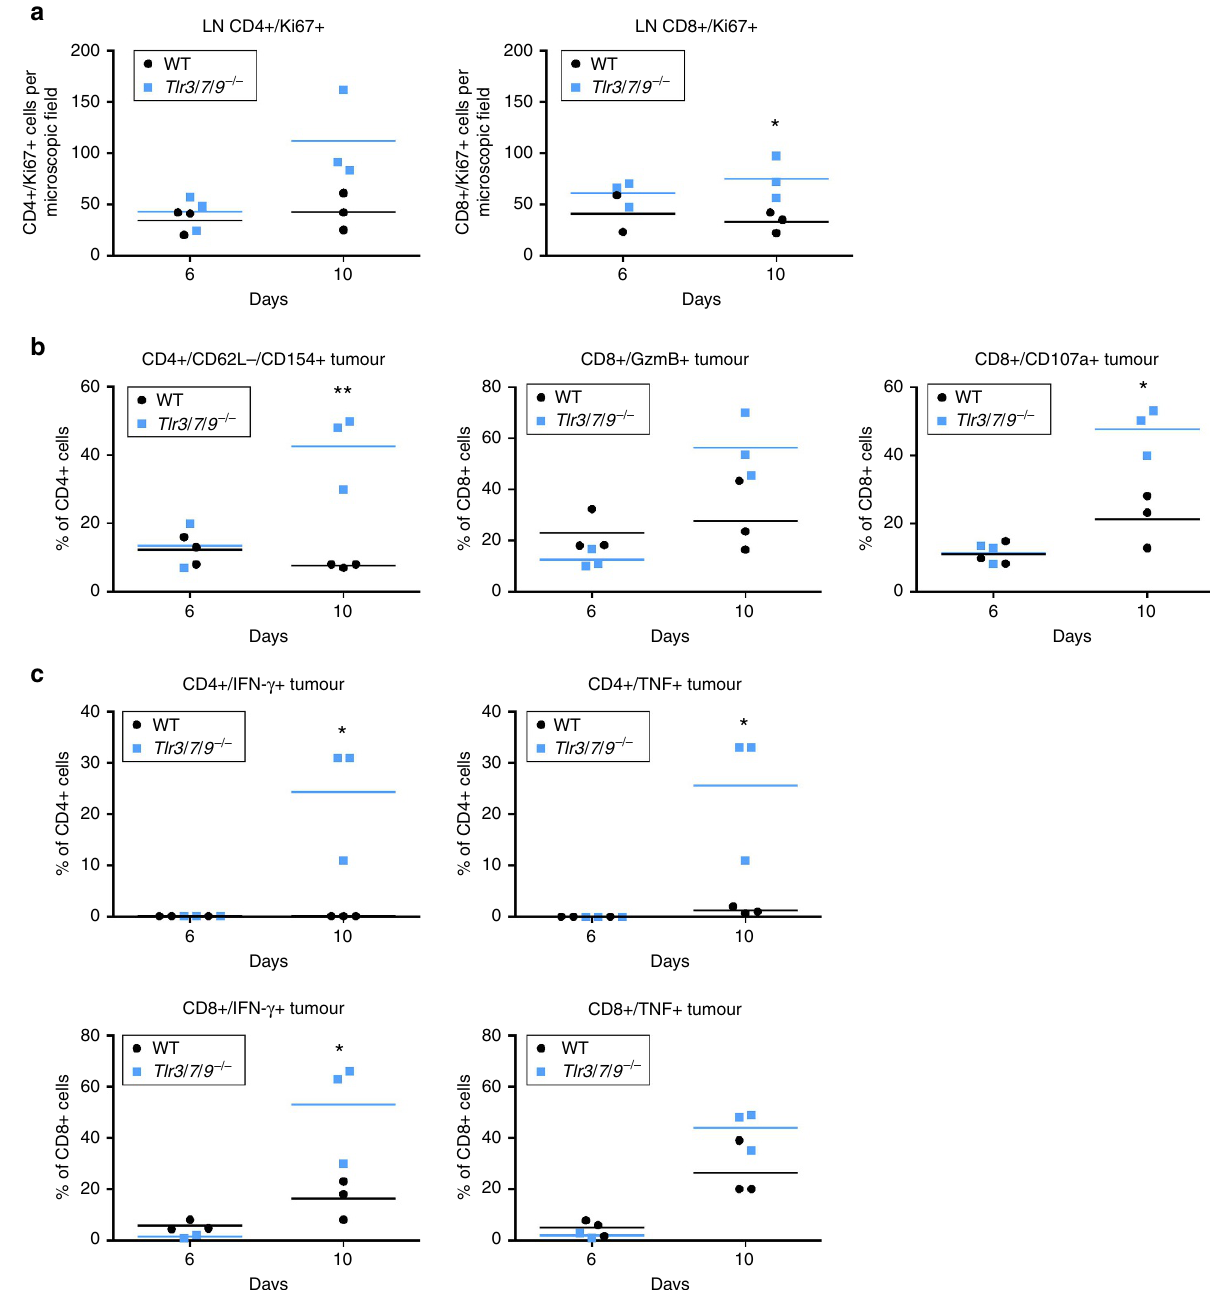
Figure 5 | T-cell activation in lymph nodes and tumour. ( a ) Lymph nodes: number of proliferating cells within the tumour-draining lymph nodes (LNs) of 6- to 12-week-old C57BL/6 WTand Tlr3/7/9 (cid:2) / (cid:2) mice was assessed at day 6 and day 10 by immunofluorescence double staining of frozen sections using a CD4 and a Ki67 antibodies. Quantification of positive cells was performed by observer-assisted counting on four randomly selected (cid:3) 200 magnified images per sample ( n ¼ 3). ( b , c ) Tumour: flow cytometric analysis of T-cell activation of tumour-infiltrating lymphocytes of 6- to 12-week-old C57BL/6 WT and Tlr3/7/9 (cid:2) / (cid:2) mice at day 6 and day 10. ( b ) Activation status of CD4 þ cells was analysed by staining of CD62L (cid:2) /CD154 þ cells. Activated CD8 þ cells are determined by showing Granzyme B þ (GzmB) and CD107a þ expression. ( c ) Cytokine production of tumour-infiltrating CD4 þ and CD8 þ cells was assessed after ex vivo stimulation with a CD3/CD28 antibodies and subsequent flow cytometry staining using a IFN- g and a TNF- a antibodies. Single values and mean (horizontal line) are shown. Results were considered significant at * P r 0.05 and ** P r 0.005 ( t